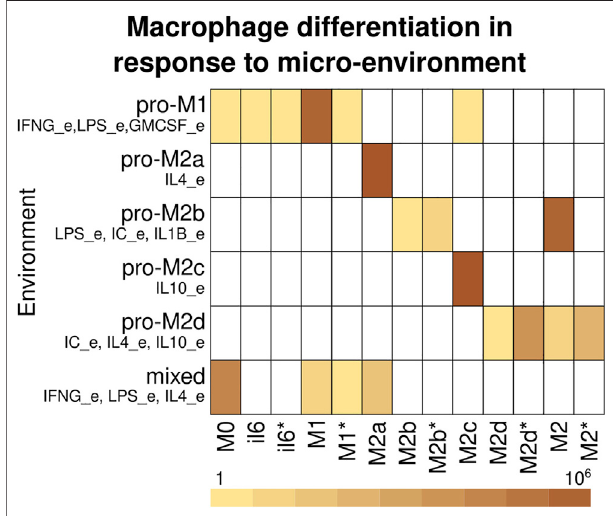
FIGURE 4 | Macrophage differentiation in response to the micro- environment. Cell types recover depending on the cytokines in the micro- environment.Therowscorrespondtotheenvironmentandthecolumnstothe cell type. The color corresponds to the basin size of the attractors that correspond to each cell type. If a cell type was not recovered on a microenvironment, it is represented with